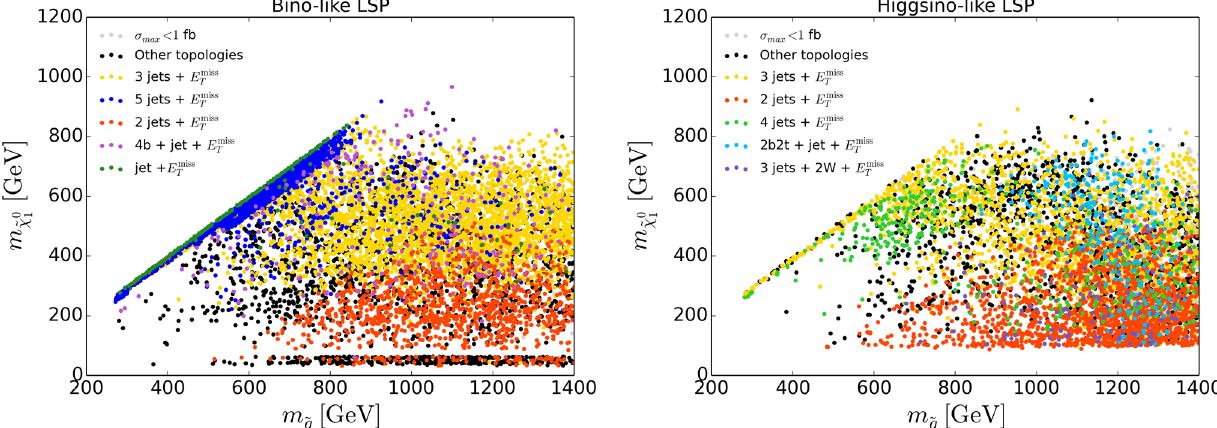
Fig. 7 Most important missing topologies for SModelS -allowed points with light gluinos. The legend lists, from top to bottom, the missing topologies with highest cross sections ordered by their by fre-